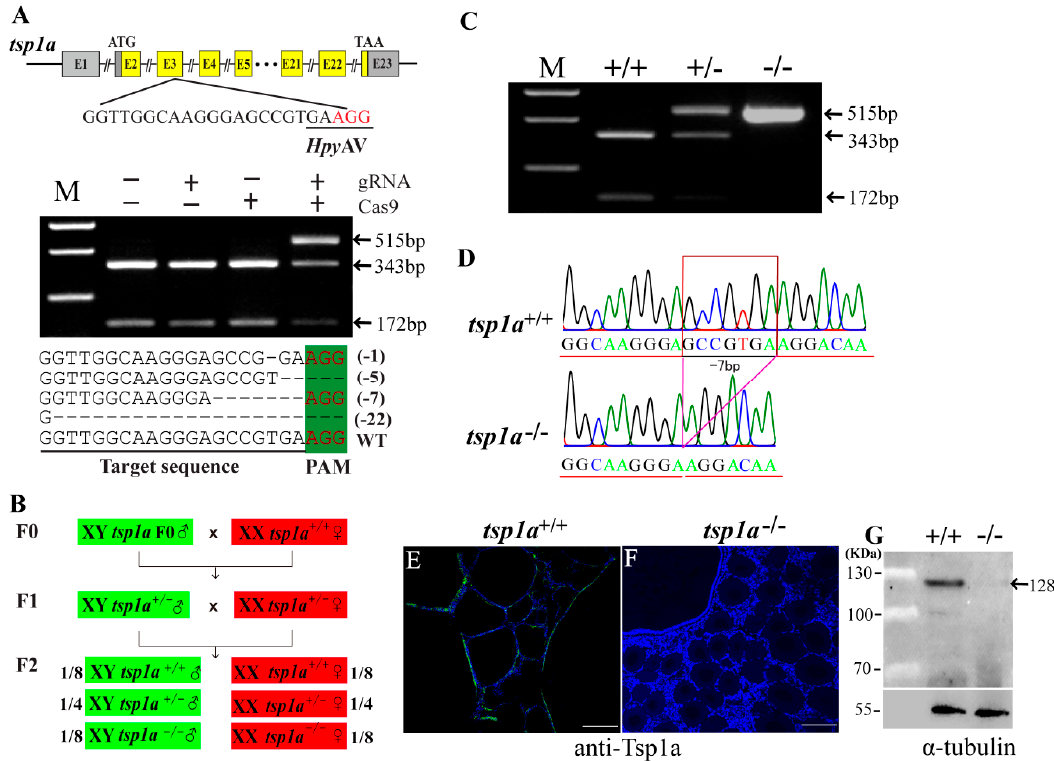
Figure 2. Efficient mutation of tsp1a by CRISPR/Cas9. ( A ) Gene structures of tsp1a showing the target site and the HpyAV restriction site. The Cas9 mRNA and gRNA were added as indicated. Sanger sequencing results from the uncleaved bands were listed. The PAM (protospacer adjacent motif) is marked in green. Deletions are marked by dashes (–) and numbers to the right of the sequences indicate the loss of bases for each allele in parentheses. The mutant fish which contains 7 base-pairs deletion was used for homozygous mutant construction of tsp1a . ( B ) Schematic diagram showing the breeding plans of tsp1a F0 to F2 fish. ( C ) Identification of F2 genotypes by restriction enzyme digestion assay. ( D ) Sequencing results of tsp1a gene from WT and homozygous mutant fish. ( E , F ) Immunofluorescence was used to test the specificity of the Tsp1a antibody. Cells with a green color indicated the positive signal. Blue fluorescence represents the DAPI signal. ( G ) Validation of the specificity of Tsp1a antibody by western blot. The Tsp1a protein was present in WT tilapia, whereas no band was observed in the mutants. Specific bands were indicated by arrow.